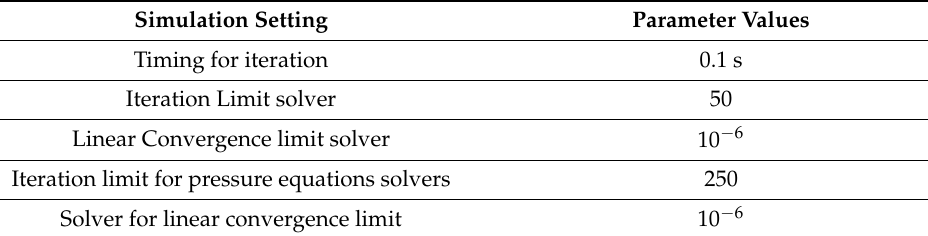
Table 2. Parameter values for the simulation runs.